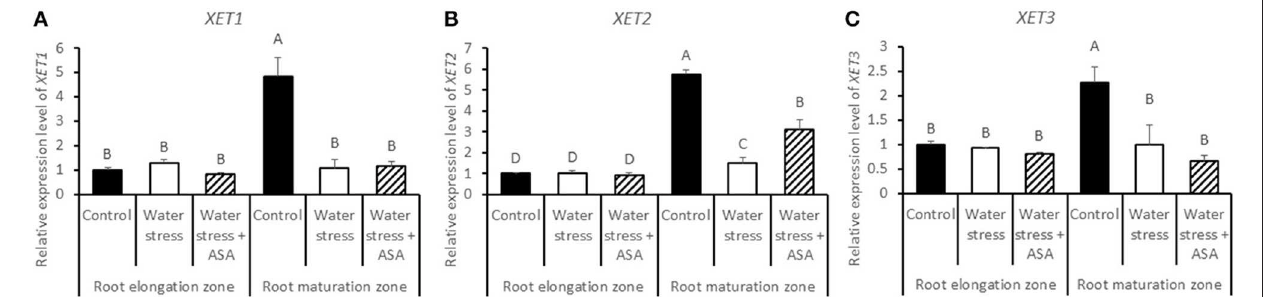
FIGURE 12 | Relative gene expression level of XET1 (A), XET2 (B), and XET3 (C) in tall fescue roots exposed to non-stress control, water stress, and water stress with ASA treatment. The data represent mean ± SE ( n = 4 replicated pots of plants and each pot with multiple plants). Columns marked with the same letter are not significantly different at p < 0.05